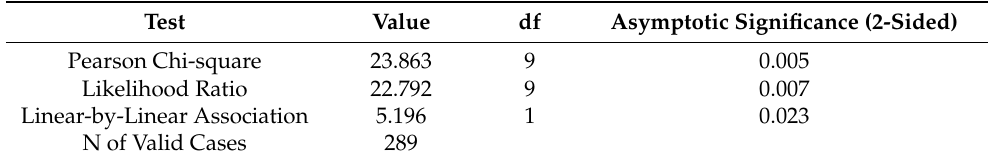
Table 6. Chi-square test on the correlation between respondents’ experience and the impact of digitization on the process of preparing/submitting financial/tax reports to the state and other third parties.